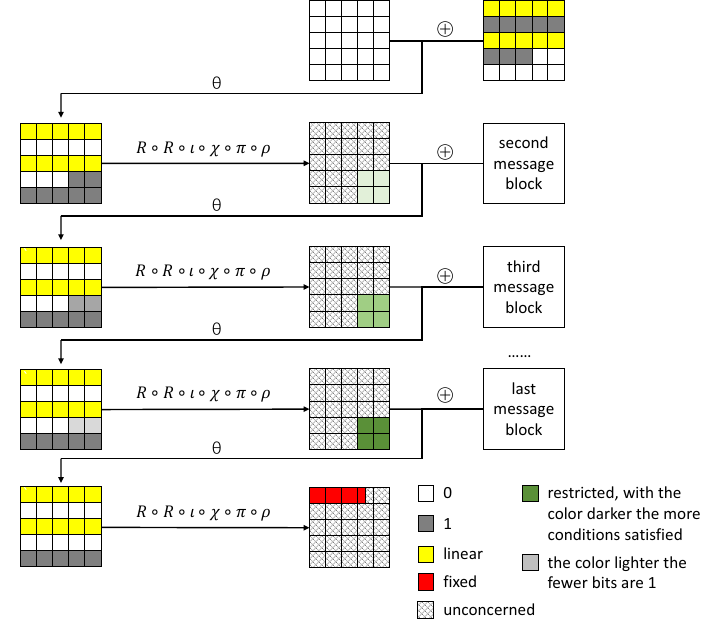
Figure 8: Iterating Strategy on 3-round Keccak-224. ( R = ι ◦ χ ◦ π ◦ ρ ◦ θ